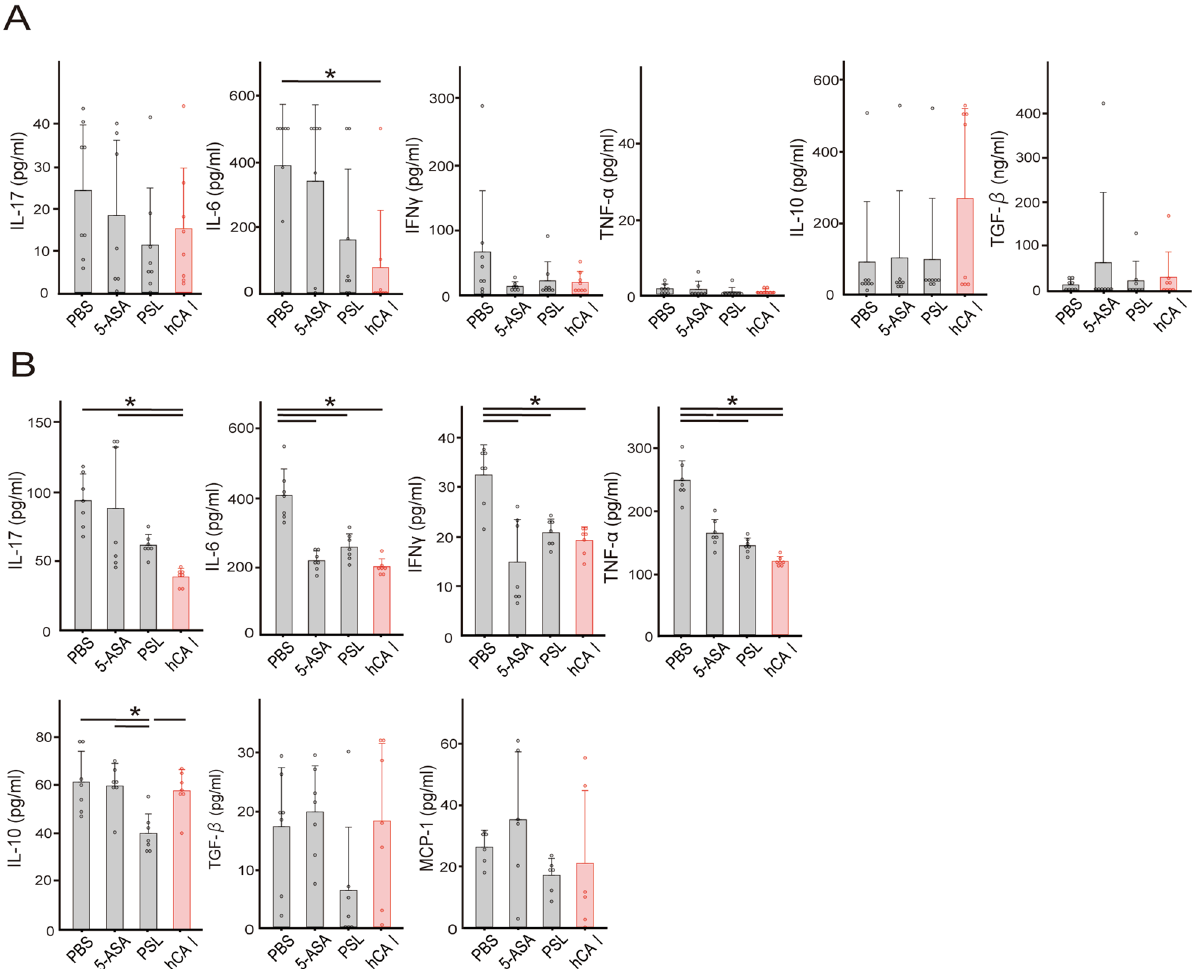
Figure 6. Inflammatory responses in the colon and MLNs in experimental colitis model mice. Four weeks after CD4 + CD25 − T cells and DCs were transferred, the colon and MLNs were collected. ( A ) Secreted cytokine concentrations from the colon, cultured ex vivo for 72 h, were measured using ELISA; mean ± SD of 7–8 mice/ group. ( B ) Secreted cytokine concentrations from MLN cells (1 × 10 6 ), cultured with PMA and ionomycin for 72 h, were measured using ELISA; mean ± SD of 6 mice/group. * P <